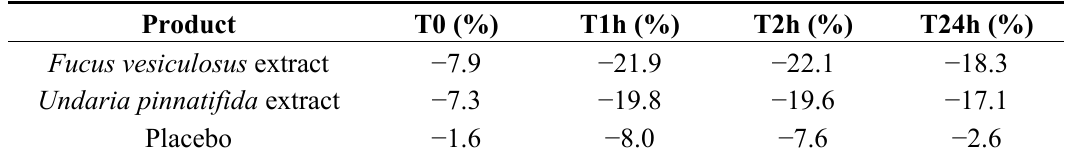
Table 8. Transepithelial water loss after application of placebo or active cream, as compared to control (Study Scheme 1); n = 25 (percent change of mean vs. control).